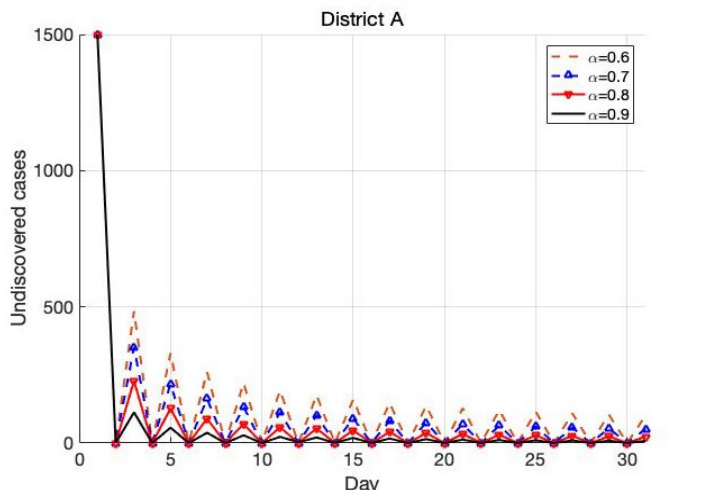
Figure 7. Model results for undiscovered cases.